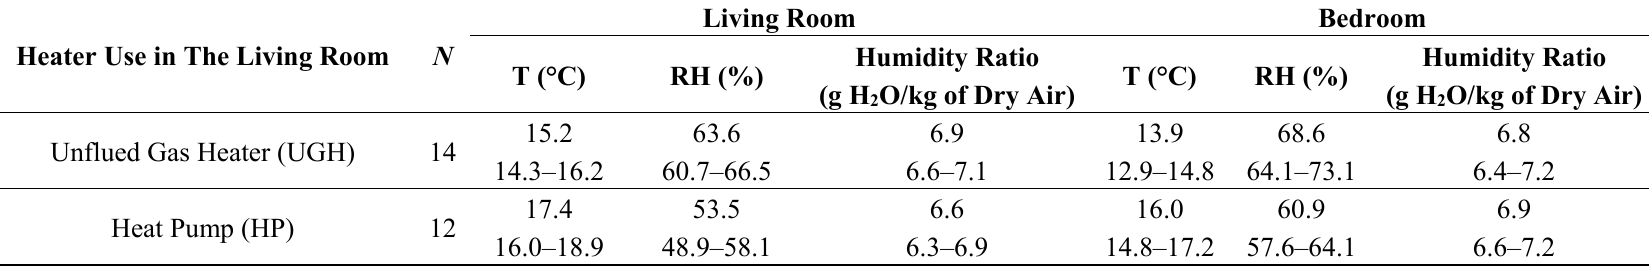
Table 1. Average [ 95% CI] temperature (T), relative humidity (RH) and humidity ratio in living rooms and bedrooms of households operating either an unflued gas heater or a heat pump